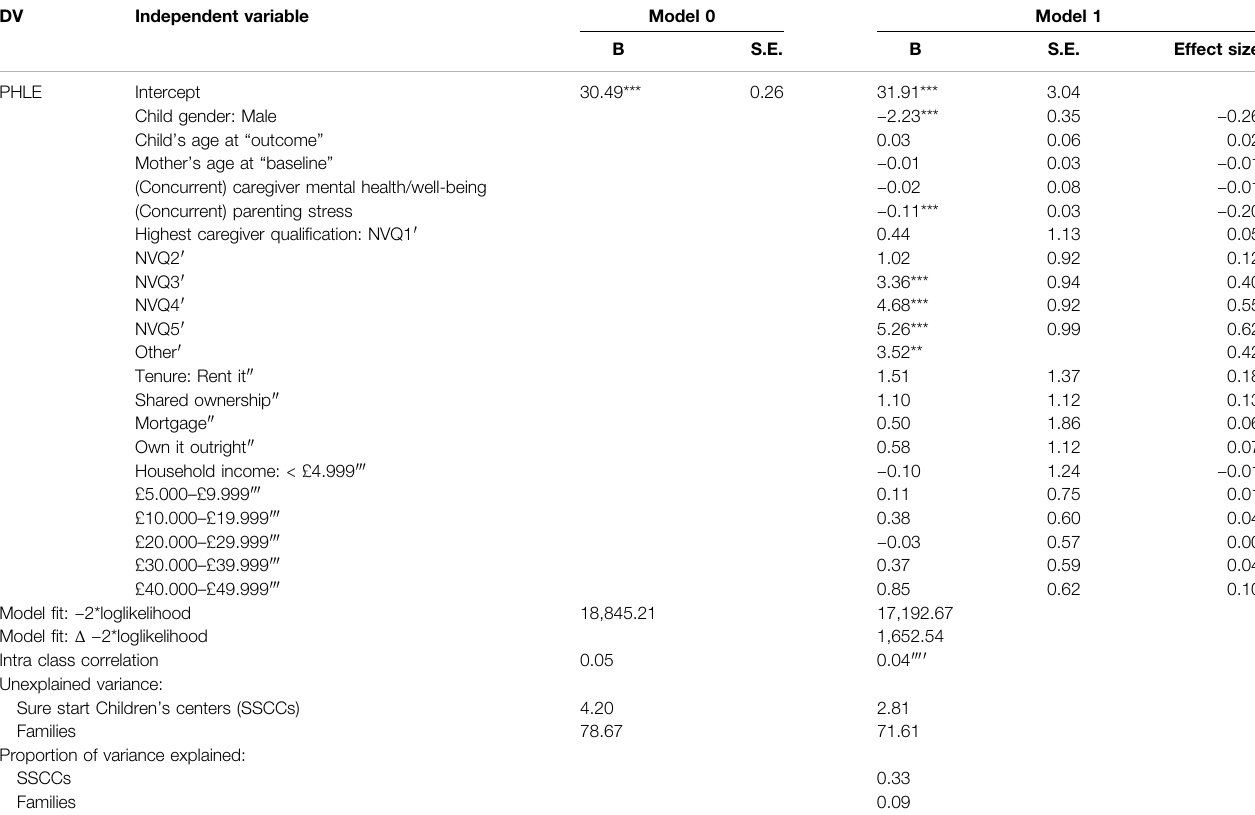
TABLE 8 | Multilevel Regression showing demographic correlates with the preschool home learning environment scale (PHLE; n (cid:1) 2,409 of the longitudinal n (cid:1) 2,608).